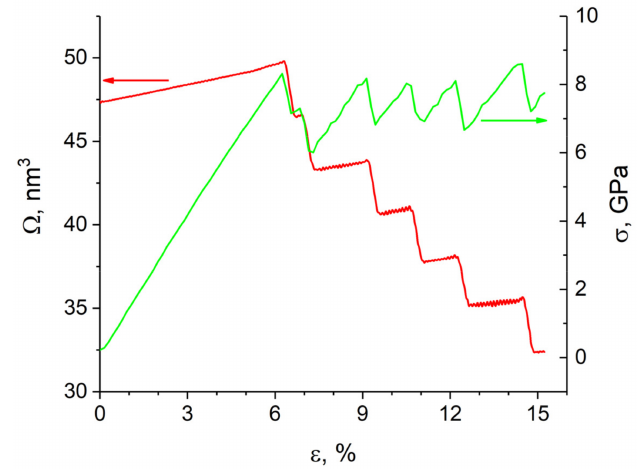
Figure 7. Variation of stress intensity of the sample (green curve) and crack volume (red curve) versus strain degree for sample with (112)[110] crack. Axis corresponding to each curve is pointed by an arrow.